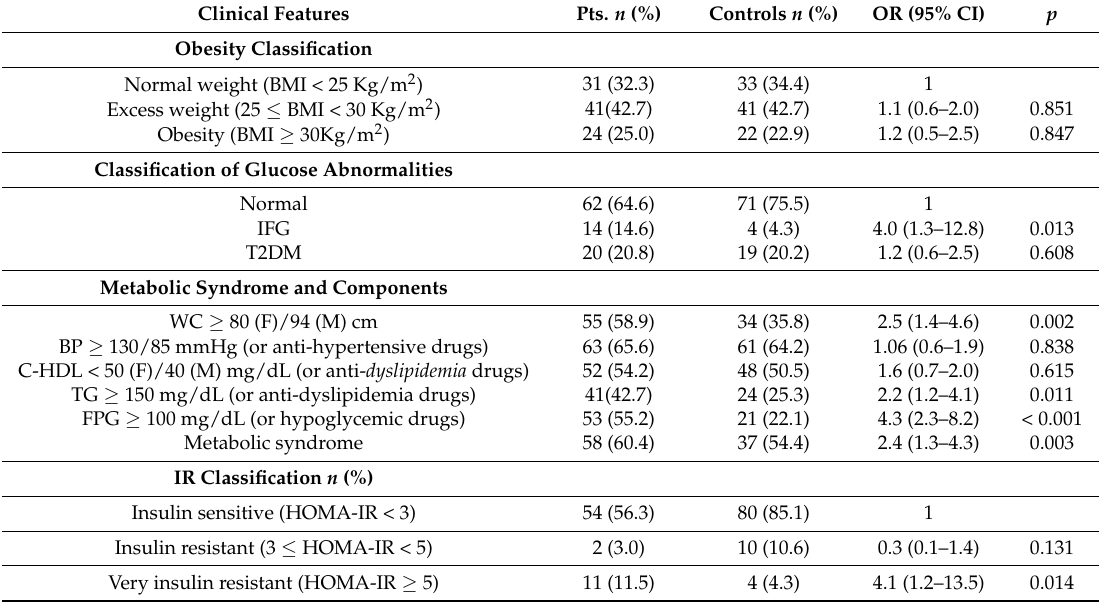
Table 4. Association of MetS, MetS components, and IR with WD GEP-NETs and controls.